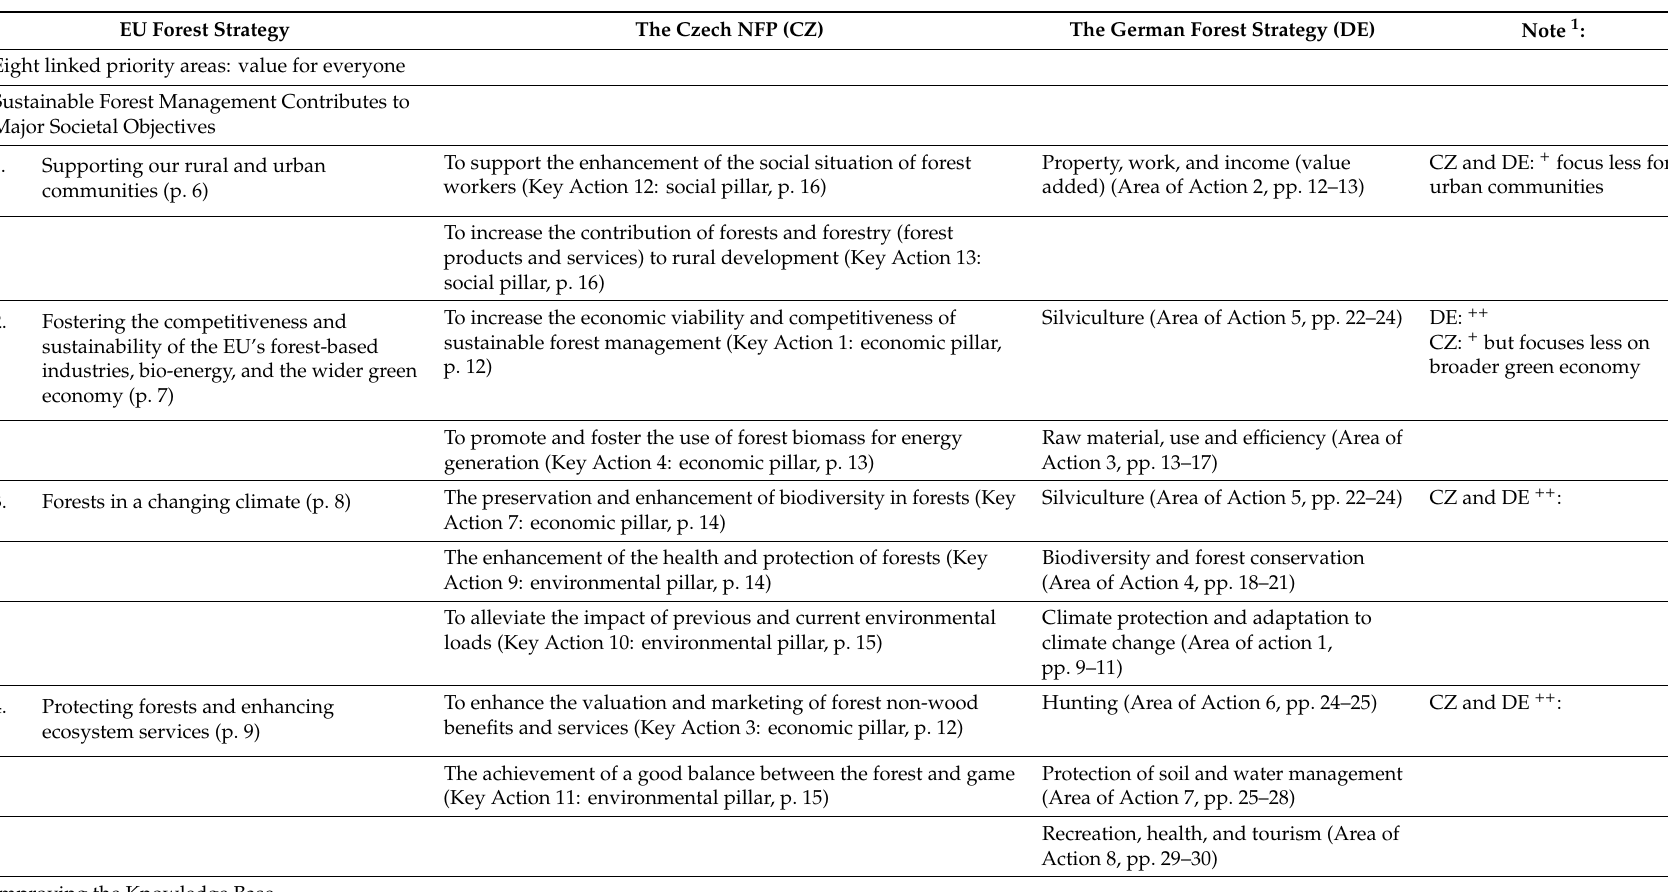
Table A2. Comparison of priorities of the forest strategy in Germany and the Czech Republic and their relationship with the EU forest strategy. EU Forest Strategy The Czech NFP (CZ) The German Forest Strategy (DE) Note 1